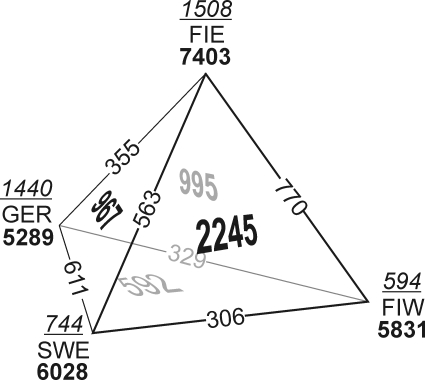
The number of monomorphic markers.The total number of monomorphic markers within each population is given in bold, and the markers that are monomorphic exclusively in one population are in underlined italics. The edges of the tetrahedron denote the markers that are monomorphic only in two populations, and the faces correspond to monomorphy shared between three populations. 21 319 SNPs that were monomorphic in all the four populations are not included in the figure. Abbreviations as in Figure 1.